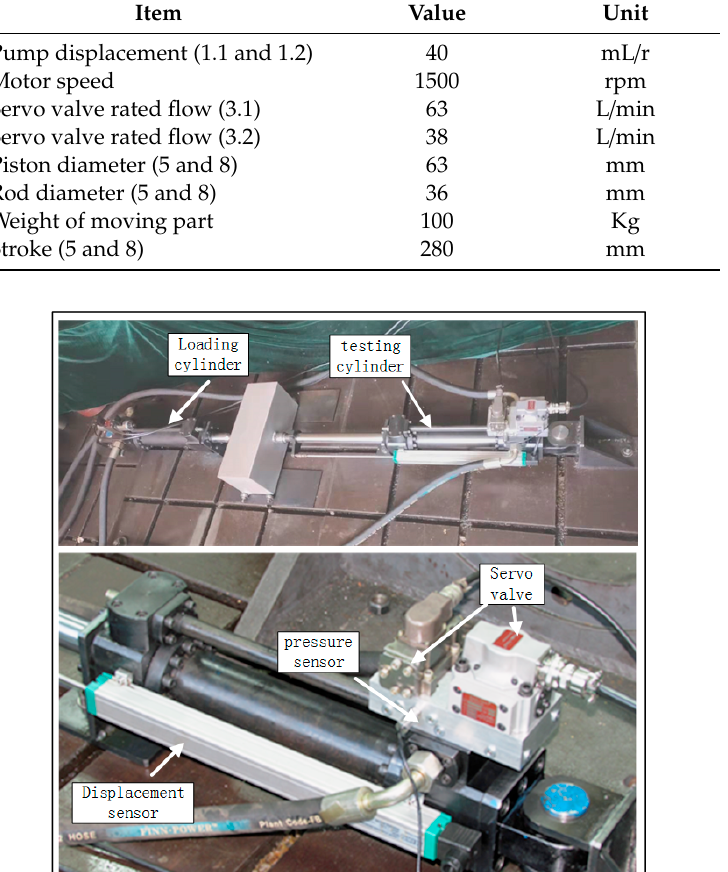
Figure 8. The photo of the test rig. Table 1. Main Specifications of the Test Rig.